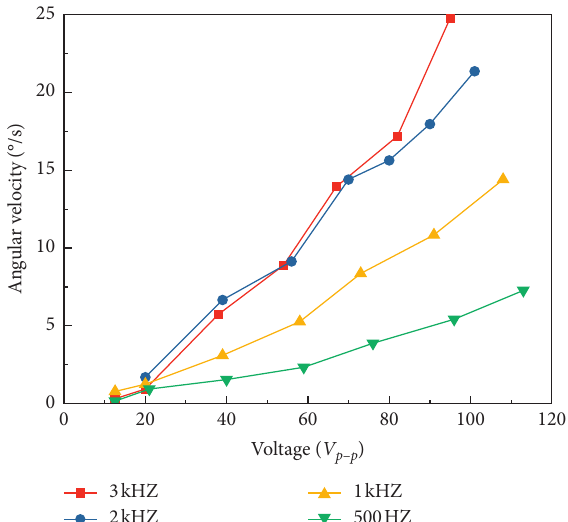
Figure 14: Velocity under different applied voltages.